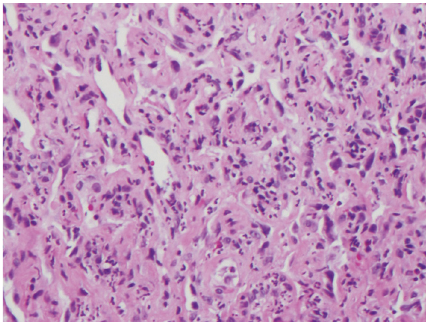
Figure 3: The anastomosing channels are readily apparent and are lined with atypical endothelial cells with enlarged and hyperchro- matic nuclei.